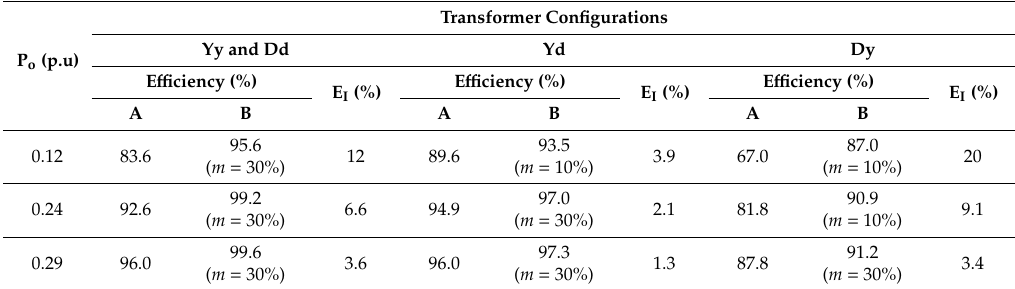
E ffi ciency improvement with continuous and intermittent operation in di ff erent transformer configurations.